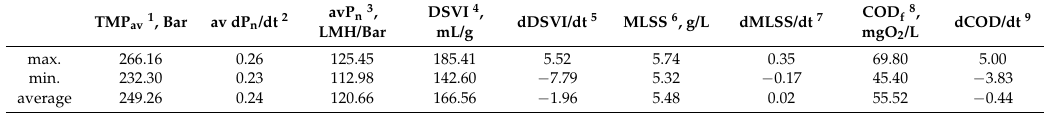
Table 5. Mixed liquor characteristics and fouling indicators during period VIII (new data).